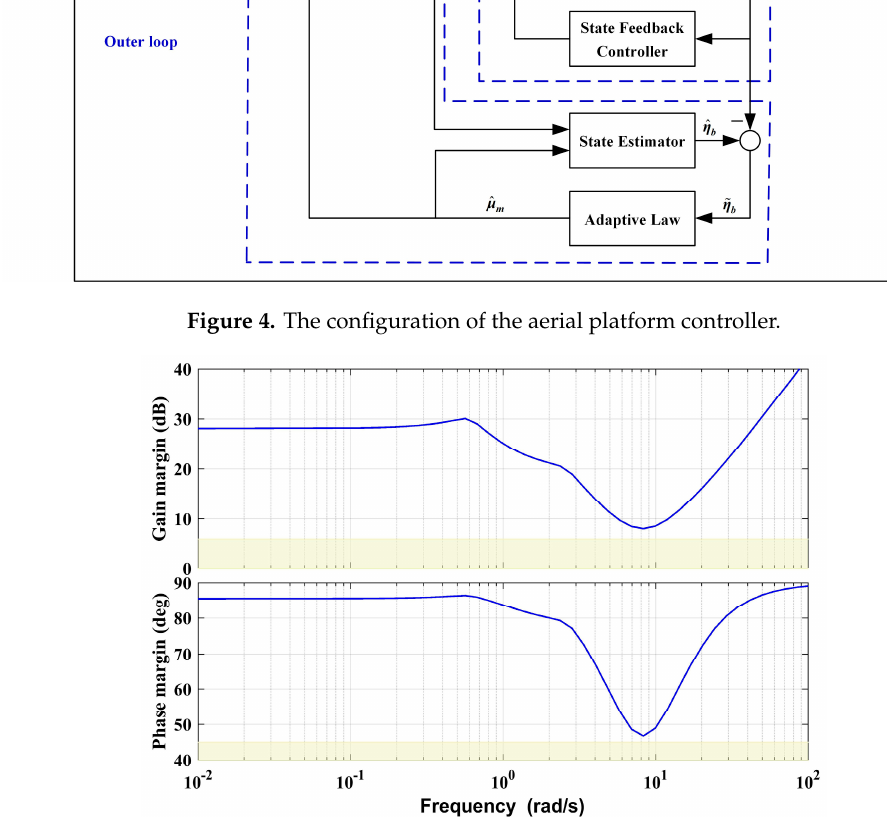
Figure 5. The stability margin of the inner loop system.